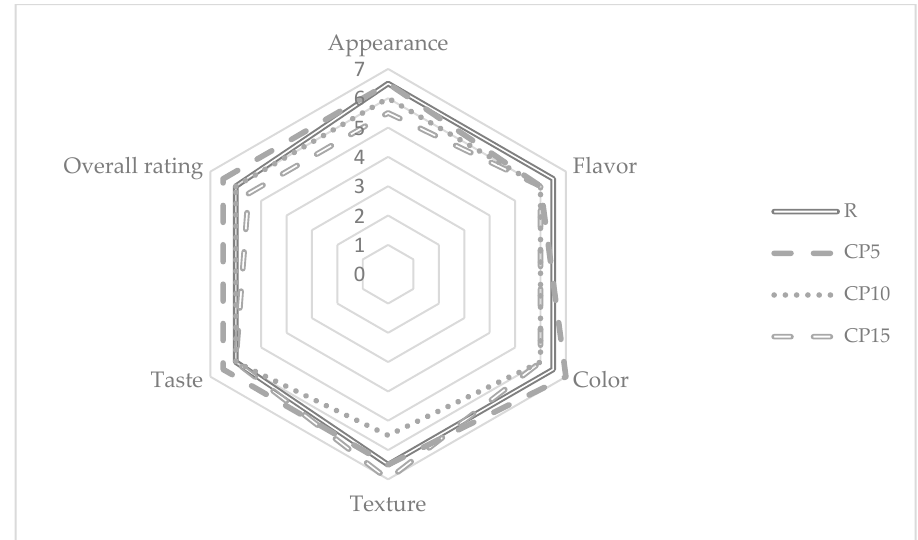
Figure 1. Consumer acceptance of obtained pasta. R, CP5, CP10, and CP15 denote pasta with cricket powder at 0%, 5%, 10%, and 15% ( w / w ), respectively.